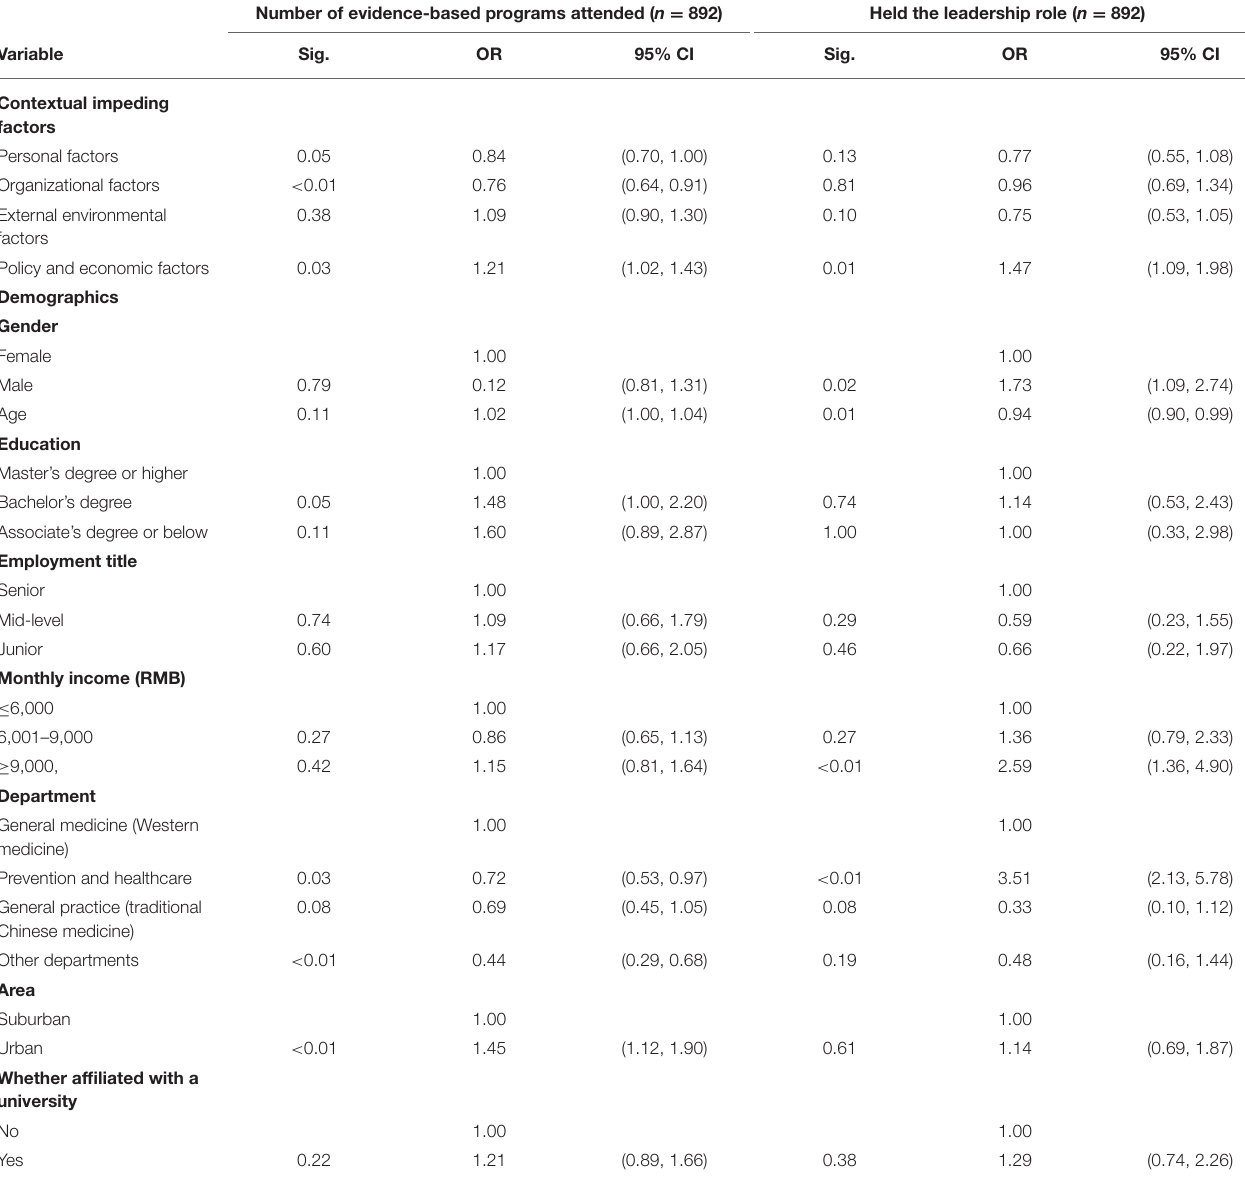
TABLE 5 | Logistic regression of evidence-based practice and whether the GPs held the leadership position in the program ( n = 892). Number of evidence-based programs attended ( n = 892) Held the leadership role ( n =